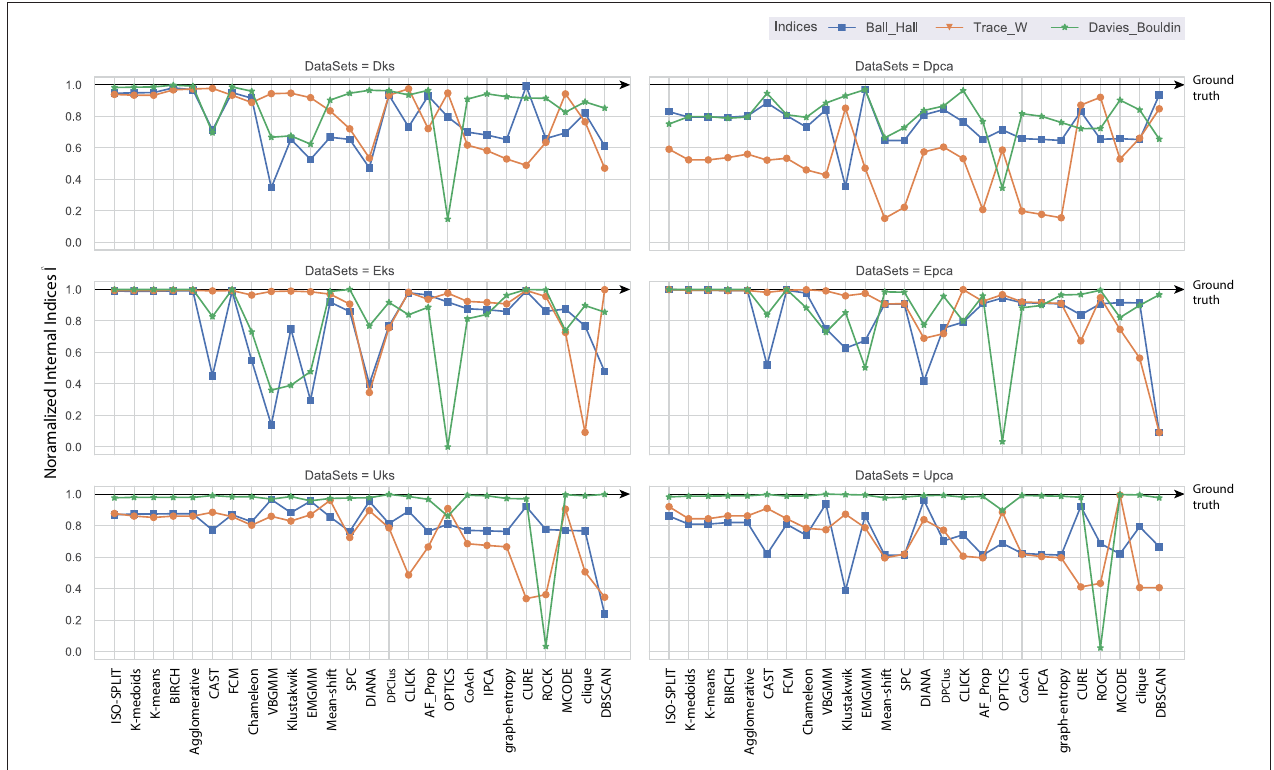
FIGURE 5 | Each plot contains normalized values of three internal indices for each of six feature-set across all algorithms. Results of each internal indices criteria I were normalized ˆ I with reference to indices of ground-truth labels using Equation (8). The normalization rule is such that a score of one indicates ground-truth and as score moves away from one toward zero indicating a drop in